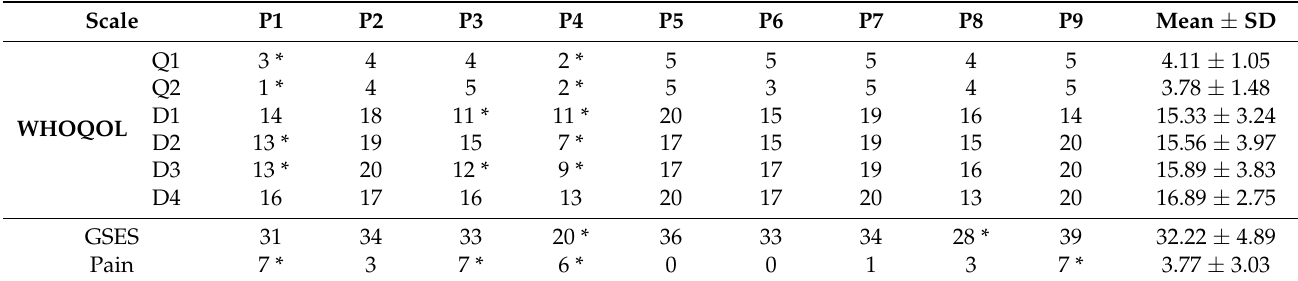
Table 2. WHOQoL-BREF and GSES scores.